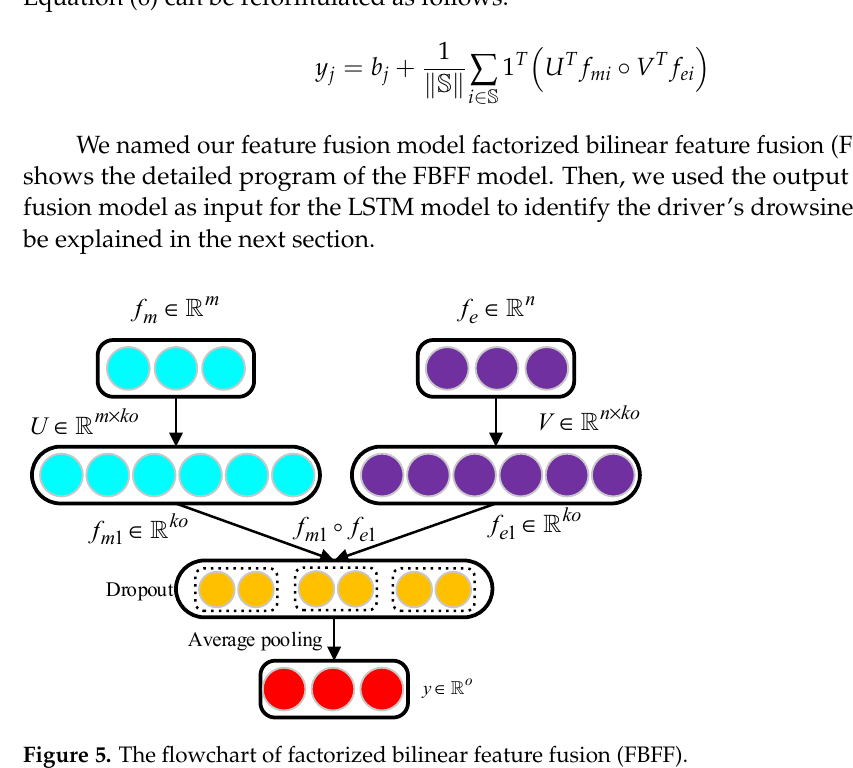
Figure 5. The flowchart of factorized bilinear feature fusion (FBFF).